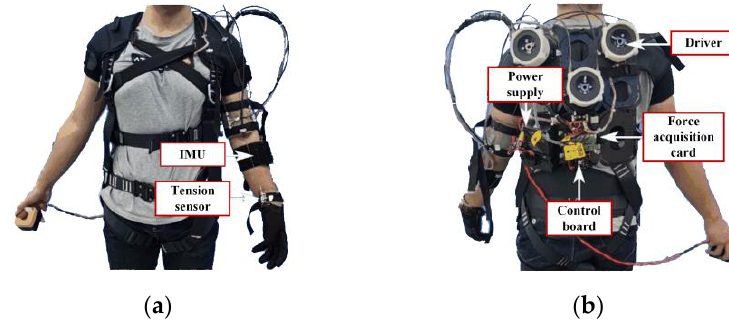
Figure 7. Pictures of an upper extremity exosuit: ( a ) the front; ( b ) the back .